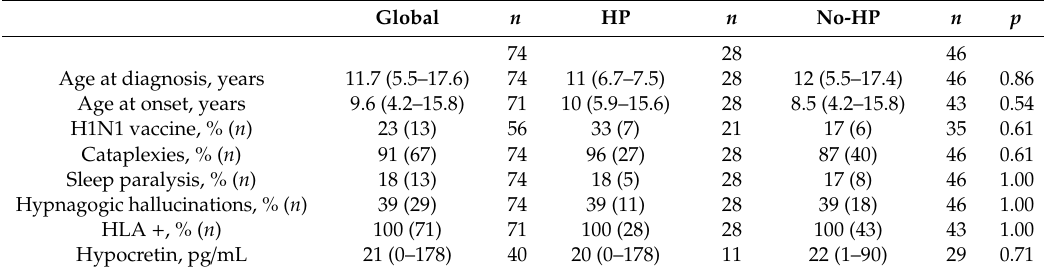
Table 2. Narcolepsy characteristics in children with and without HP.